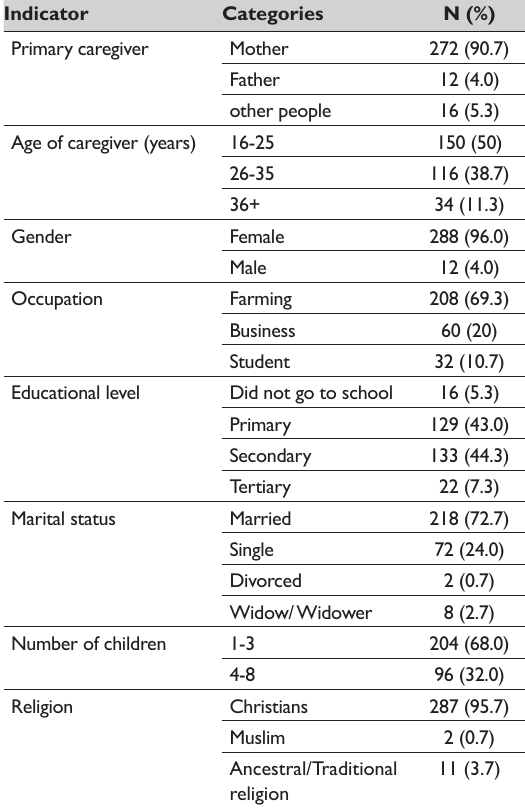
Table 1: Socio-demographic characteristics of caregivers